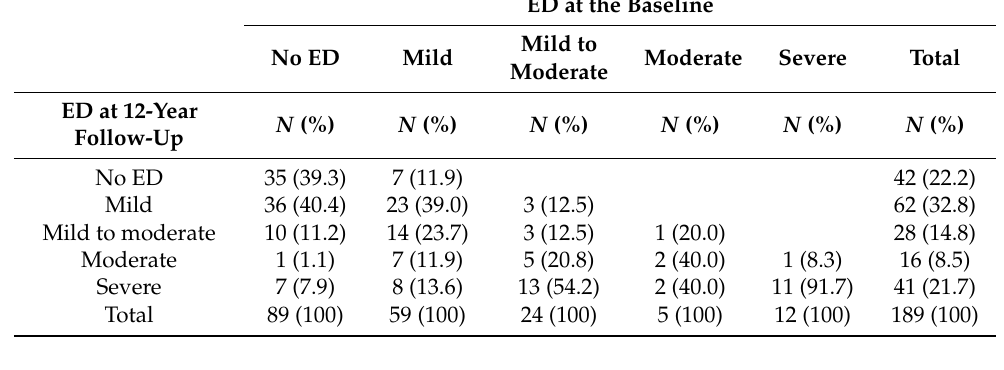
Table 3. Prevalence and changes in erectile dysfunction from the baseline to the 12-year follow-up.